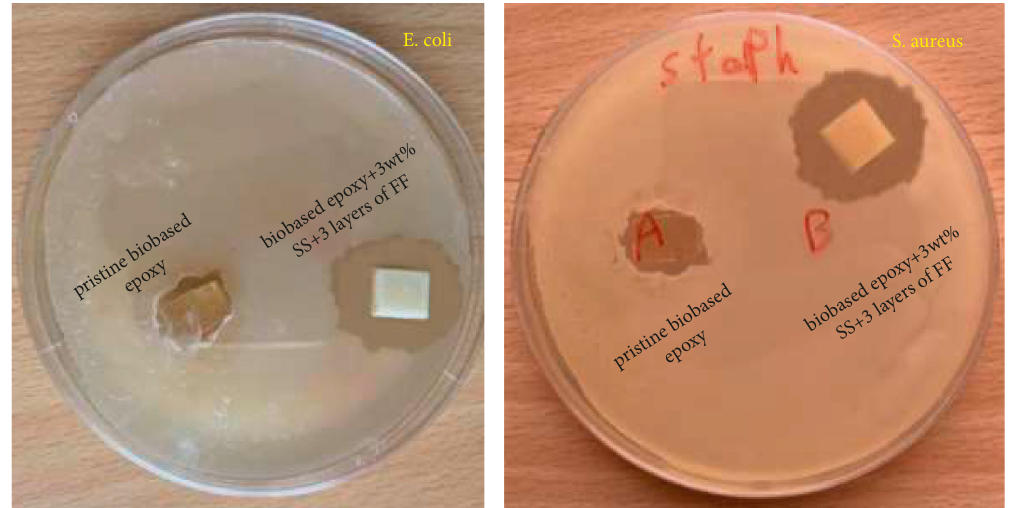
Figure 9: Zone of inhabitation of pristine biobased epoxy and 3 wt% SS-FF-loaded biobased epoxy against E. coli and S. aureus .